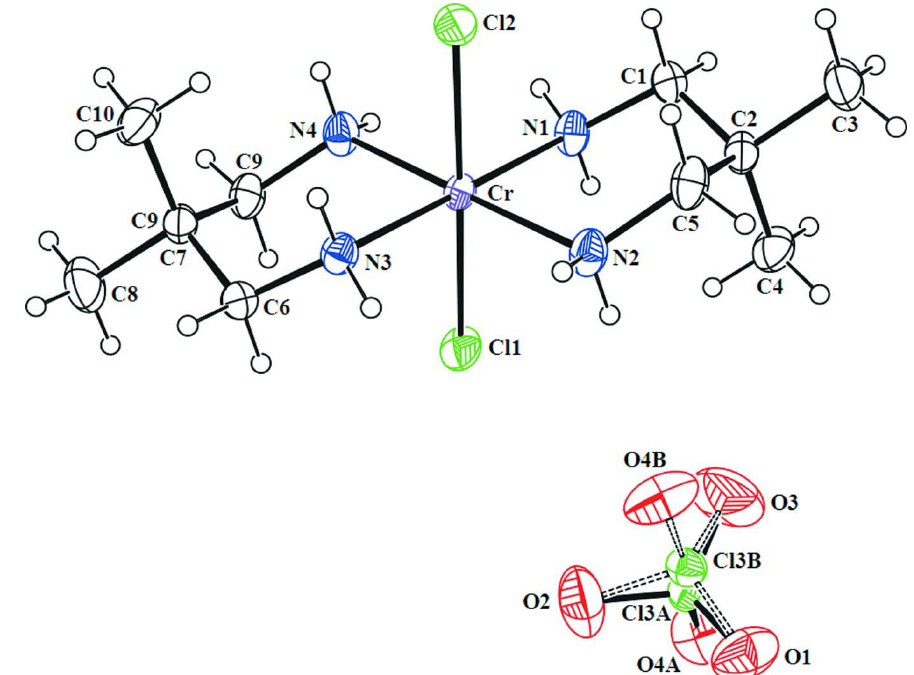
Perspective view (30% probability level) of title